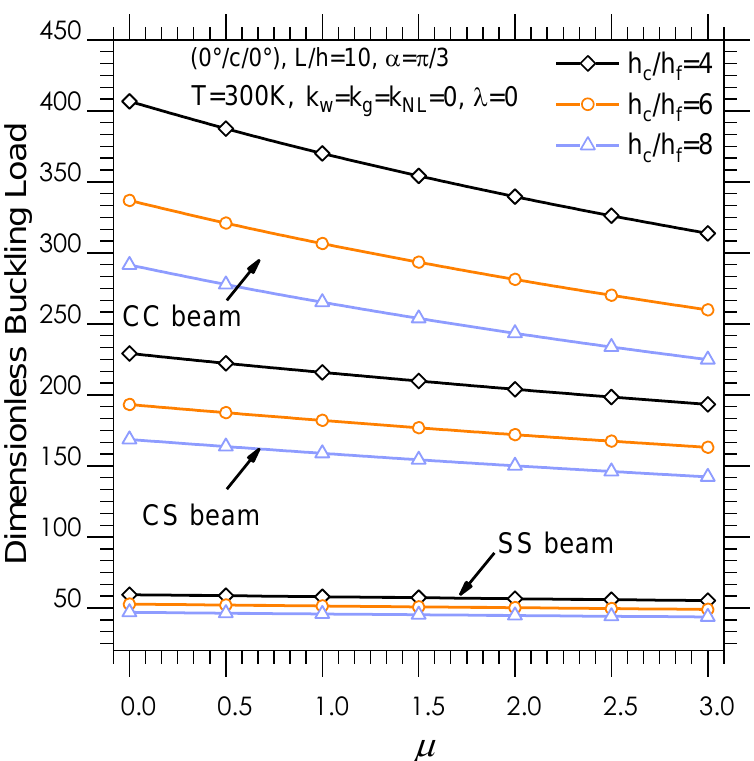
Figure 7. Dimensionless buckling load versus the nonlocal parameter.